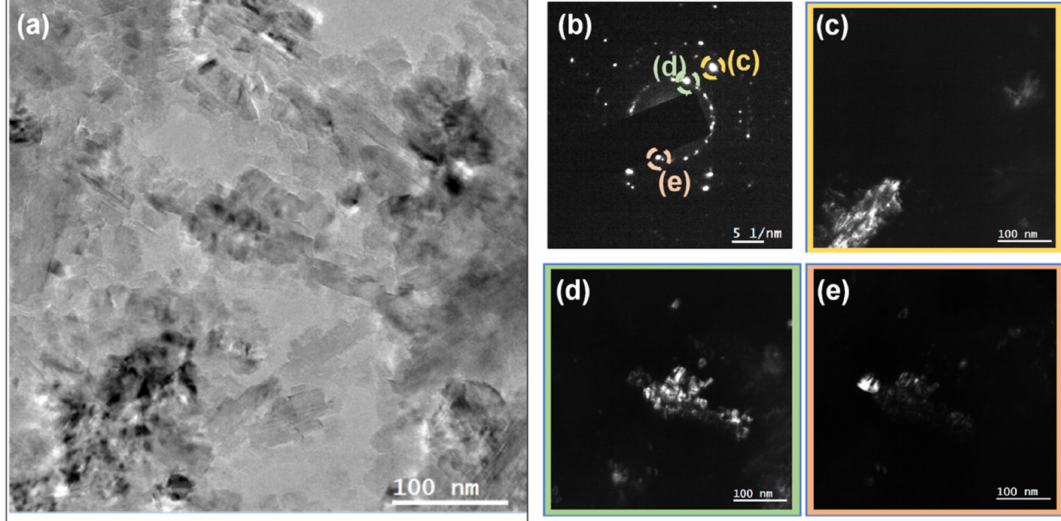
Figure 5. ( a ) BF TEM micrograph of the sample grown with 2% N 2 . ( b ) SAED pattern of the region shown in ( a ) using an aperture with 200 nm diameter. ( c – e ) DF micrographs of the reflections marked on the SAED